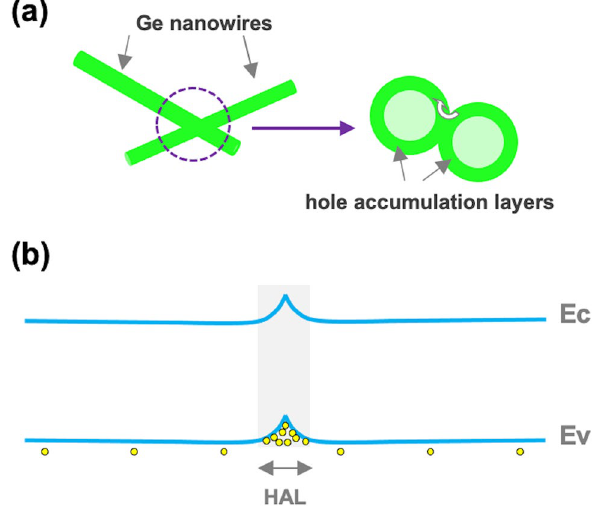
Fig. 4 a Simplified illustration of two crossing Ge NWs and of the cross section at NW/NW contacts; the white arrow indicates the hole cur- rent path which occurs through the NW/NW interface and along the outer shells of Ge NW. b Schematic representation of energy band bending of NW/NW junction; Ev: top of valence band, Ec: bottom of conduction band, HAL: hole accumulation